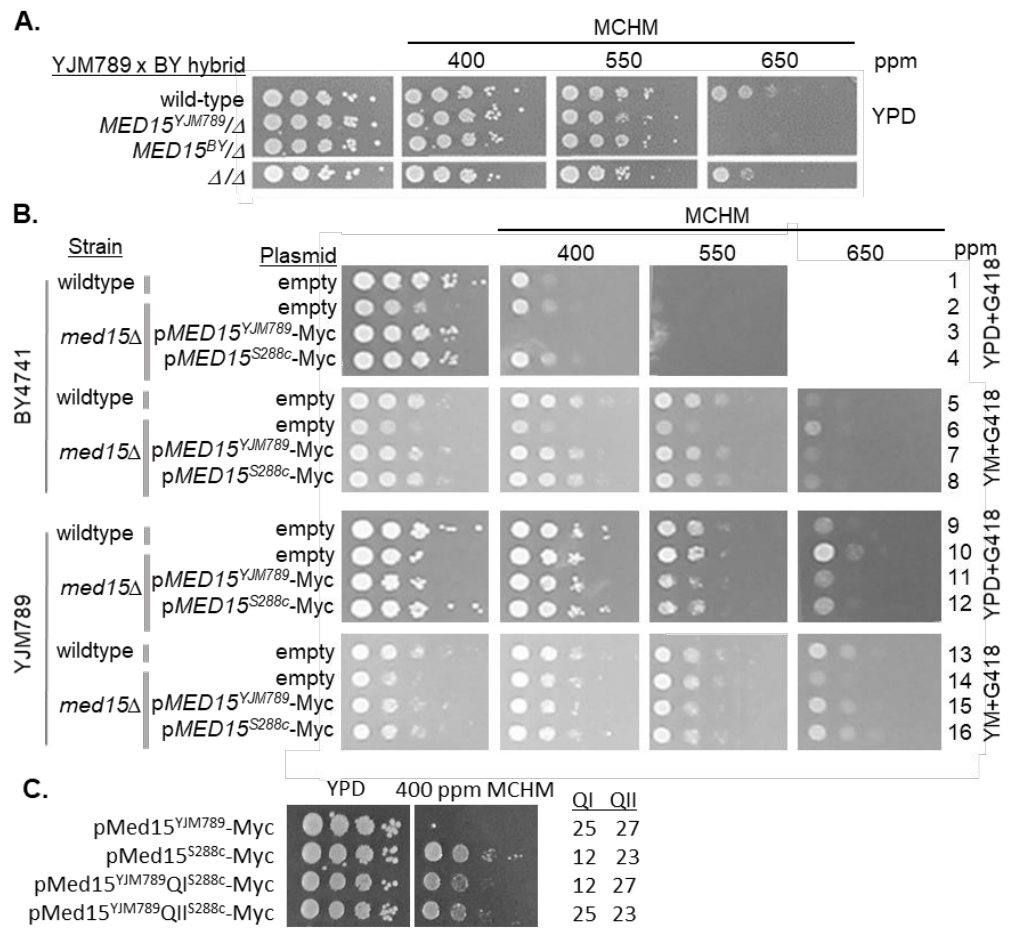
Figure 2. Genetic variation in Med15 contributed to variation in the MCHM response. ( A ) Reciprocal hemizygotes of Med15 in BY4741 × YJM789 hybrids were grown on MCHM in YPD. Med15 was tagged at the chromosomal locus with 13xMyc at the C-terminal end or knockout with a dominant drug marker in haploid parents. The yeast was then mated and diploids were selected. ( B ) Med15 allele swap in BY4741 and YJM789 was carried out by cloning Med15-13xMyc with KanR onto pRS316. Med15 plasmids were transformed into the wildtype and med15::NatR stains in the BY4741 and YJM789 (YJM789K5a, a MATa prototroph) backgrounds. Plasmids were maintained via growth on YPD with G418. Glutamate was used as the nitrogen source in minimal media (YM) with histidine, uracil, leucine, and methionine to supplement BY4741 such that G418 would be selective and maintain the plasmid. The empty plasmid was pGS35 ( KanR ). ( C ) Growth of BY4741 med15 mutants expressing polyQI and polyQII domain swaps in Med15 YJM789 -Myc. The length of each polyQ for each allele is noted to the right of the figure.